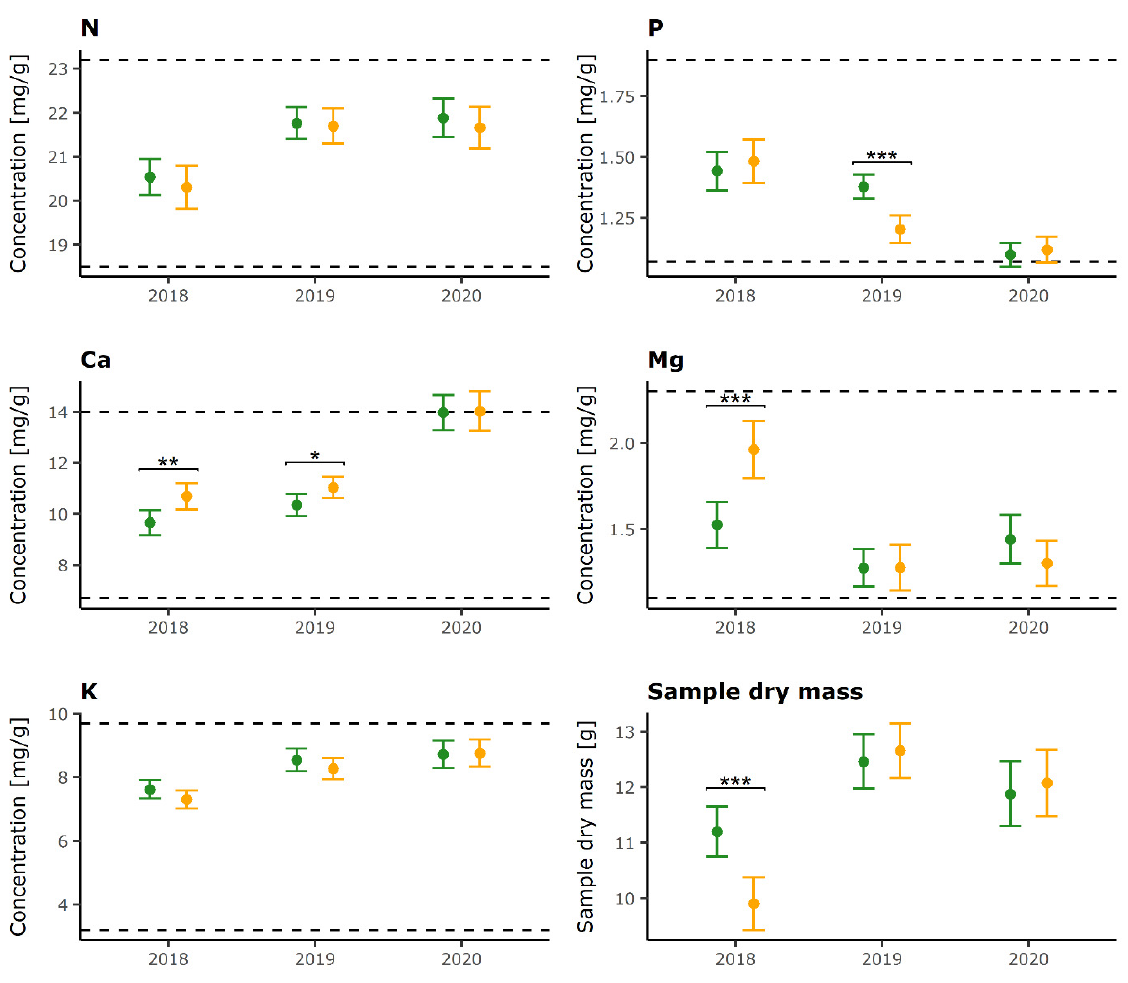
Figure 1. Mean foliar concentrations and sample dry mass (dots) with confidence intervals (vertical bars) for LD (green color) and HD trees (orange color) on all plots within sampling years. Dotted lines represent lower and upper critical value for normal range of foliar N concentrations for common beech according to Mellert and Goettlein [40]. Only significant differences in foliar concentrations between LD and HD categories determined by the Holm–Bonferroni method are indicated (* p < 0.05, ** p < 0.01, *** p < 0.001).